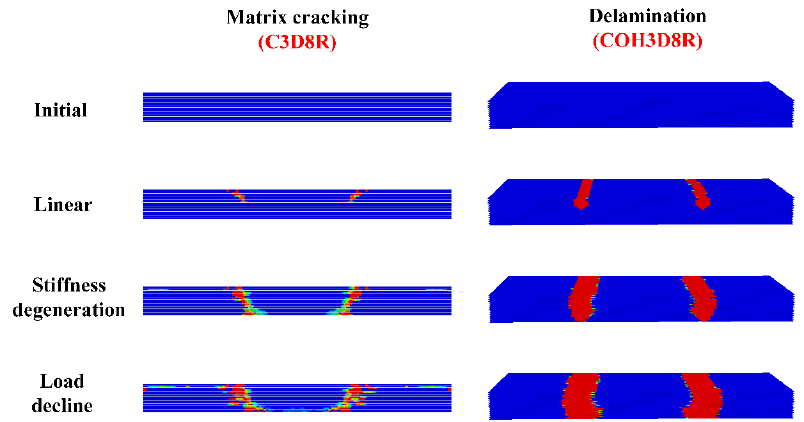
Figure 17. Progressive damage to the lower lap plate of hexagonal bolt joints at 600 °C .